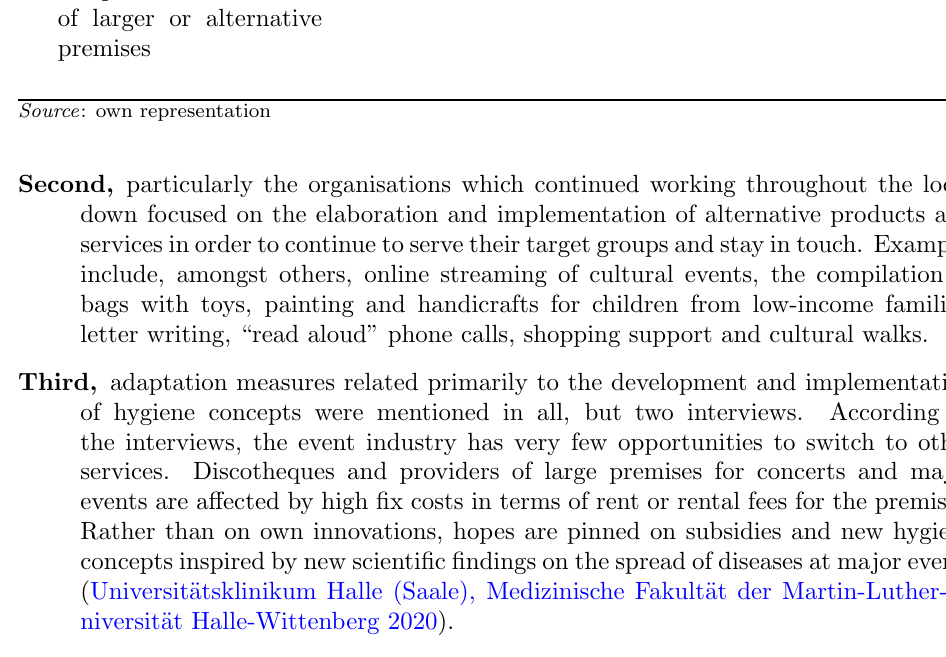
Medium- to long-term adjustments (changes on landscape